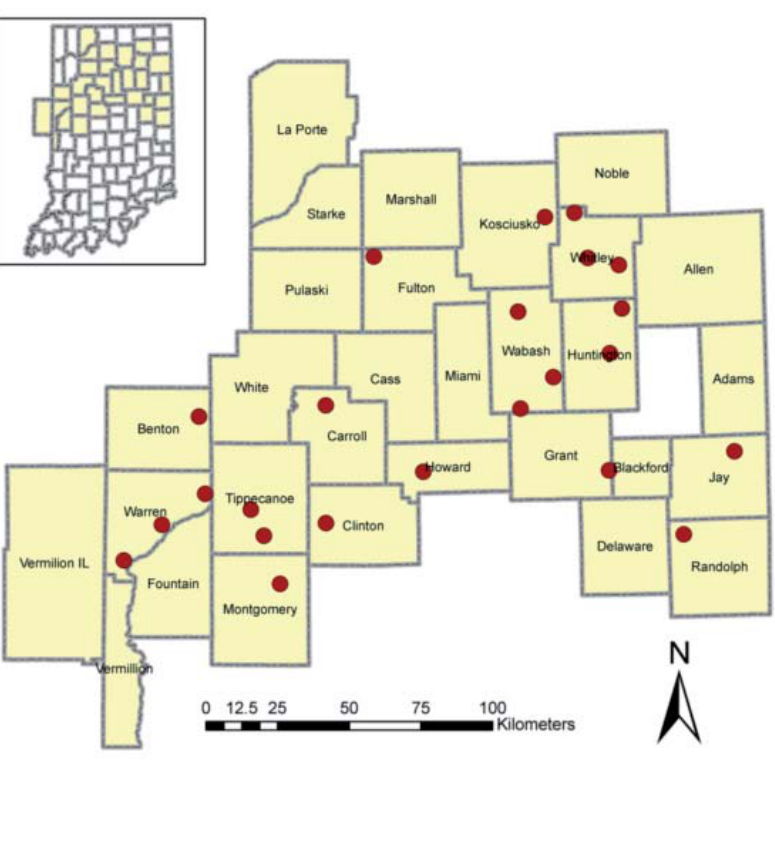
Figure 2. The counties sampled in northern Indiana, USA. Points indicate the location of a sampled forest patch. The total extent of these counties was used as a boundary when extracting land cover values from the National Land Cover Dataset. One county, Vermillion County, is in the neighbouring state of